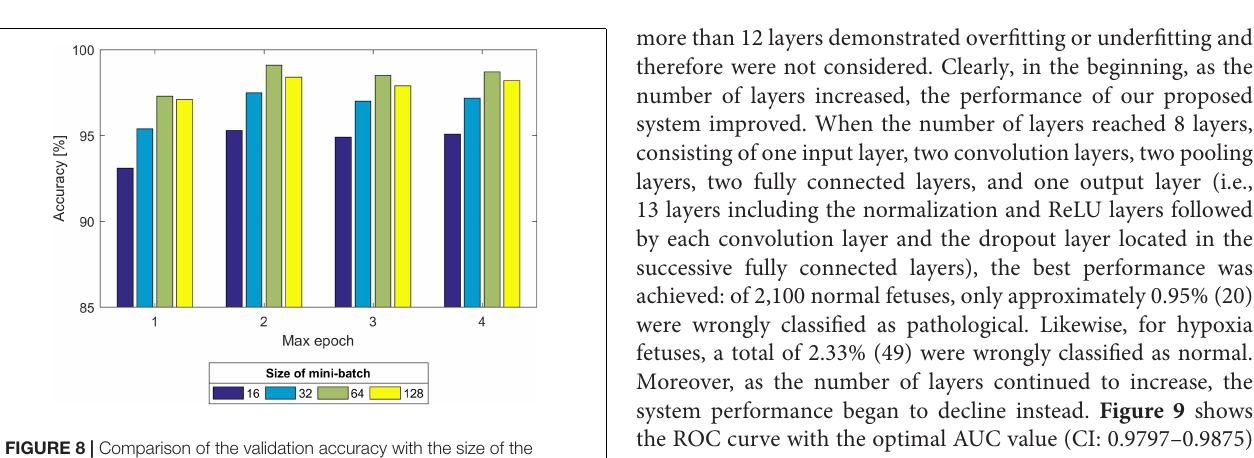
FIGURE 8 | Comparison of the validation accuracy with the size of the mini-batch and max